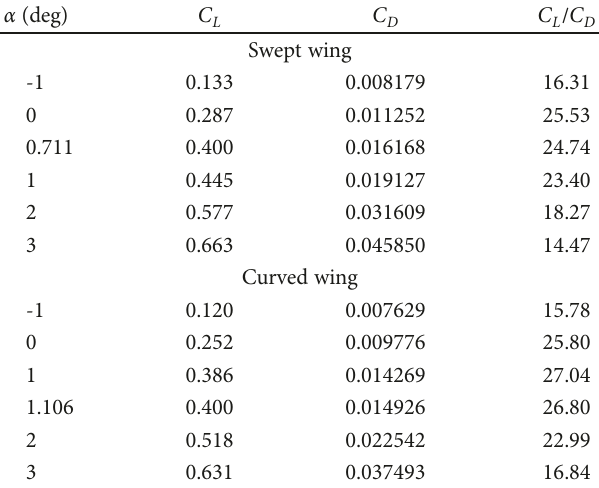
Figure 10: Supersonic region (swept wing: isoview rear).